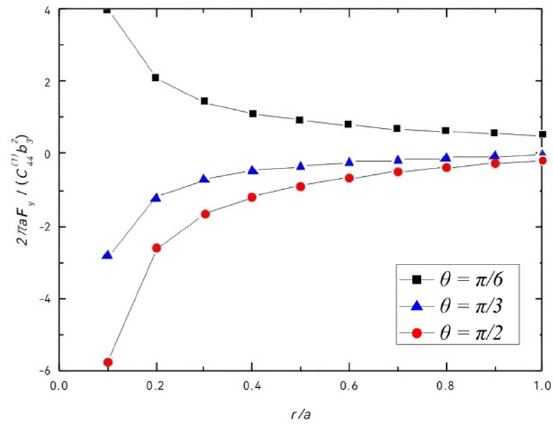
( 1 ) ) vs. r / a b 2 3 44